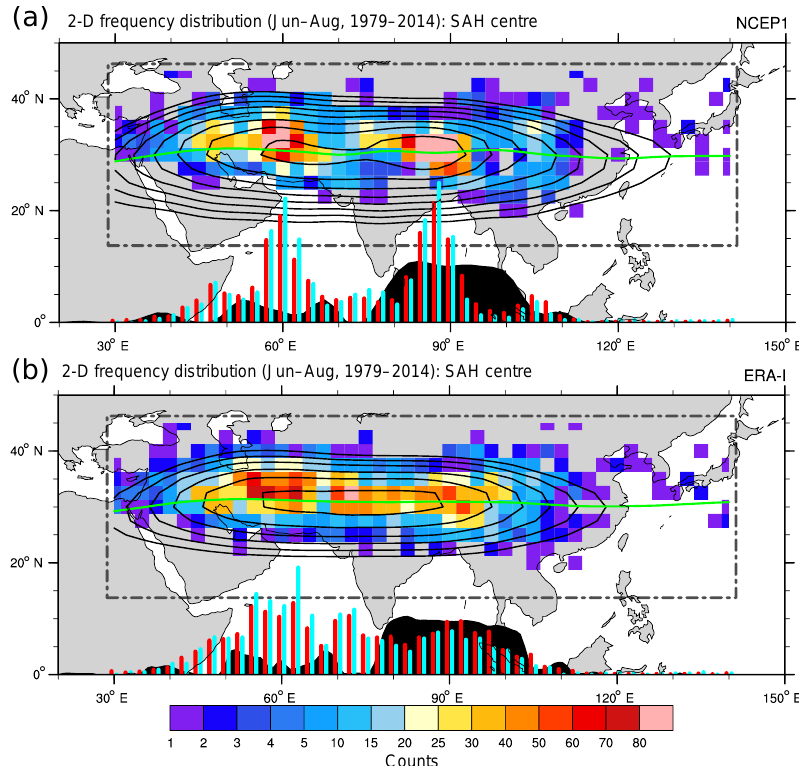
Figure 1. (a, b) Colour shading indicates the two-dimensional frequency of occurrence of the SAH centre at 100hPa as diagnosed by (a) NCEP-1 and (b) ERA-I over June to August 1979–2014 based on daily values (2.5 ◦ × 2.5 ◦ bins; note the non-linear colour scale). The box marked by the grey dashed line indicates the range of the data that are used to diagnose the centre. Black contours show the long-term seasonal (JJA, 1979–2014) mean of the geopotential height (contour levels starting at 16.72km and a spacing of 15m) and the green line shows the long-term mean location of the ridgeline (zero zonal wind) at 100hPa. On the longitude axis, black shading indicates (a) NCEP- 1 orography (at T62 resolution) and (b) ERA-I orography (0.75 ◦ resolution ∼ ERA-I native resolution) at ∼ 31.5 ◦ N (approximately the ridgeline), with 1 ◦ corresponding to 500m. Red (cyan) bars indicate the one-dimensional PDF (bins of 2.5 ◦ ) of the daily location of the SAH centre over the June–August (July–August) period 1979–2014 (1980–1994) with 2 ◦ corresponding to